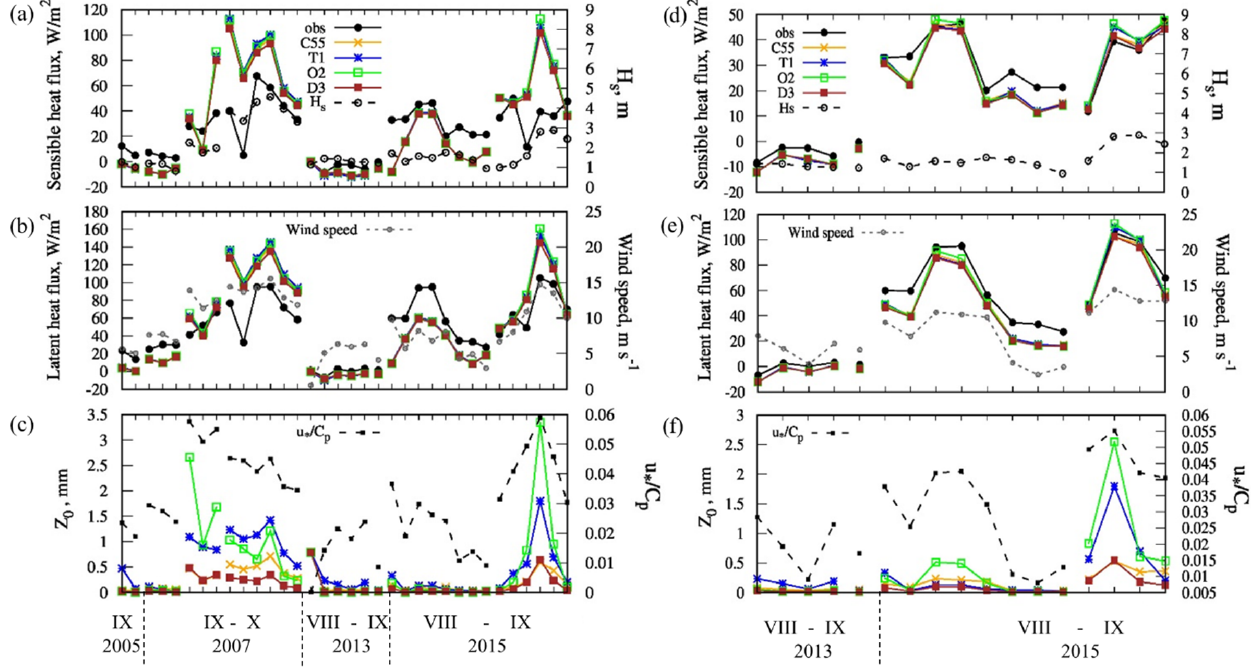
Figure 10. Sensible (a, d) and latent (b, e) heat fluxes and roughness length (c, f) according to NABOS observations (black solid line) and calculated using various roughness parameterizations (solid colored lines). Calculations are made with reanalysis (a–c) and observation data (d–f) (where observations of wind speed, temperature and radiative fluxes are available). Also, significant wave height H s from WWIII simulations (a–d) , wind speed from reanalysis (b) and observations, (e) and inverse wave age u ∗ /c p (c, f) are shown.